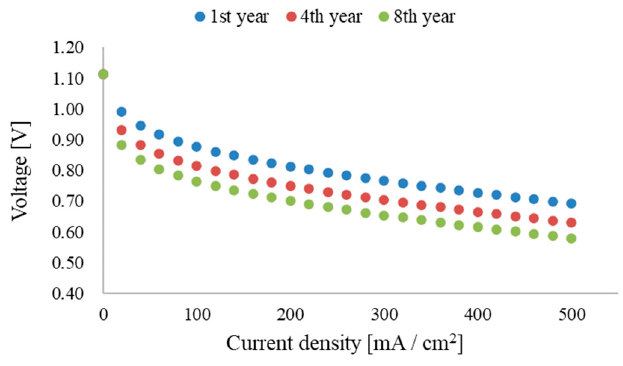
Figure 6. Simulated ECSA and average Pt particle radius transitions.